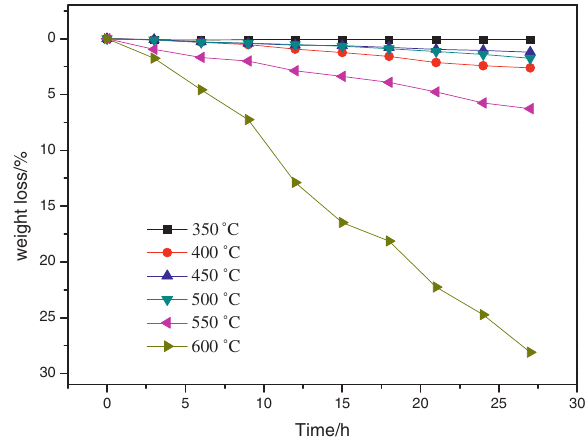
Figure 1: Weight loss vs time of sodium nitrate molten salt at different